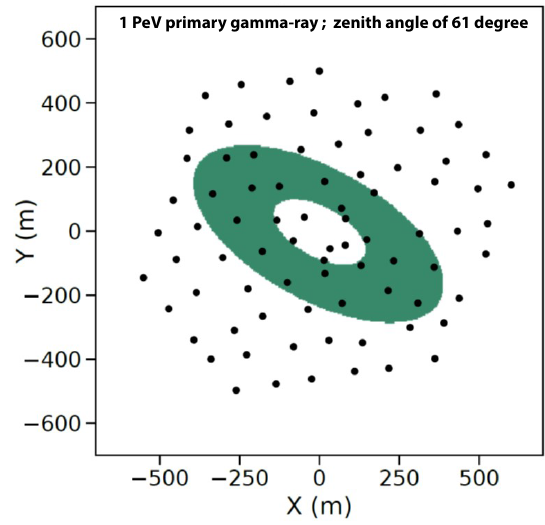
Figure 10. Footprint of a 1 PeV gamma-ray shower at 100-190 MHz. The black dots represent the 81 antenna positions. Green represents an amplitude which is easily detectable by the SKALA antenna. Only the Cherenkov ring is visible at this energy. It is su ffi cient to have three antennas within the Cherenkov ring, in order to detect and reconstruct the